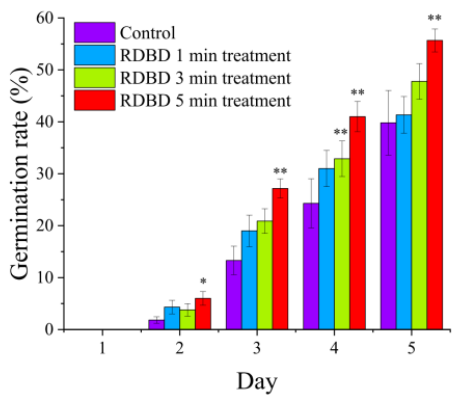
Figure 5. Spinach seed germination rate for each treatment day and treatment time. The experiment was repeated three times with 150 seeds. (* denotes p < 0.05 and ** denotes p < 0.01).